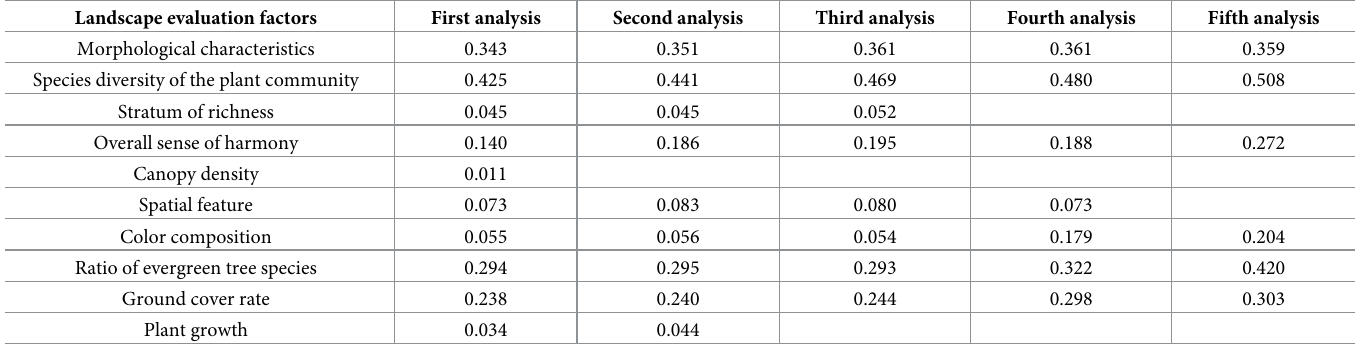
Table 3. Partial correlation analysis of landscape